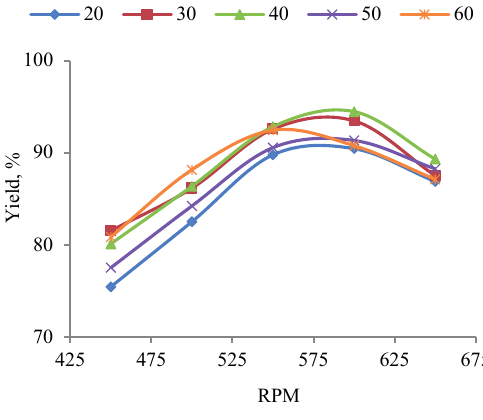
Fig. 6. Effect of stirring velocity on biodiesel production from Waste Soybean